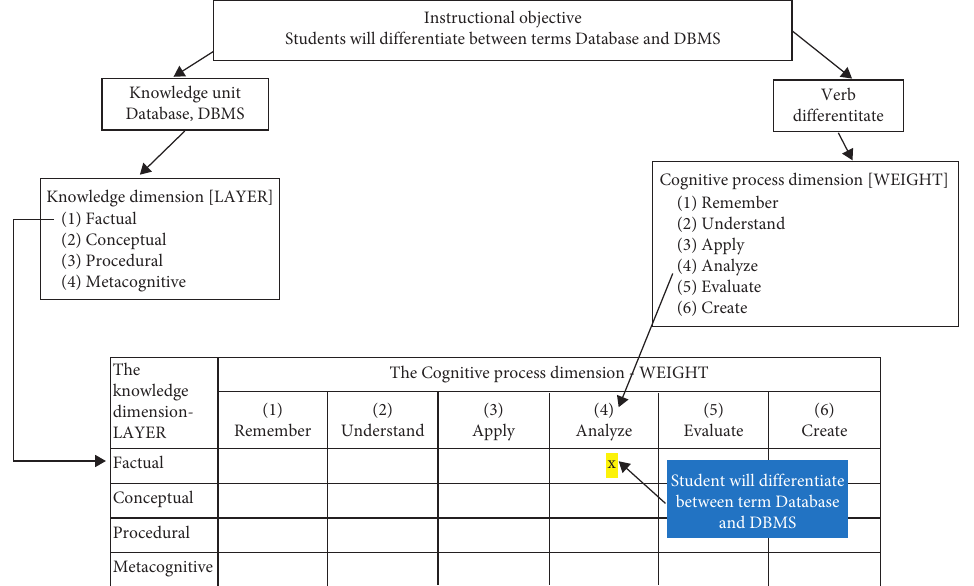
Figure 1: Construction of edges for the outcome: “Students will differentiate between terms database and DBMS ” results with two nodes (knowledge units): database and DBMS and the verb differentiate establishing the edge with weight 4 in cognitive process dimension (analyze) at the layer of factual